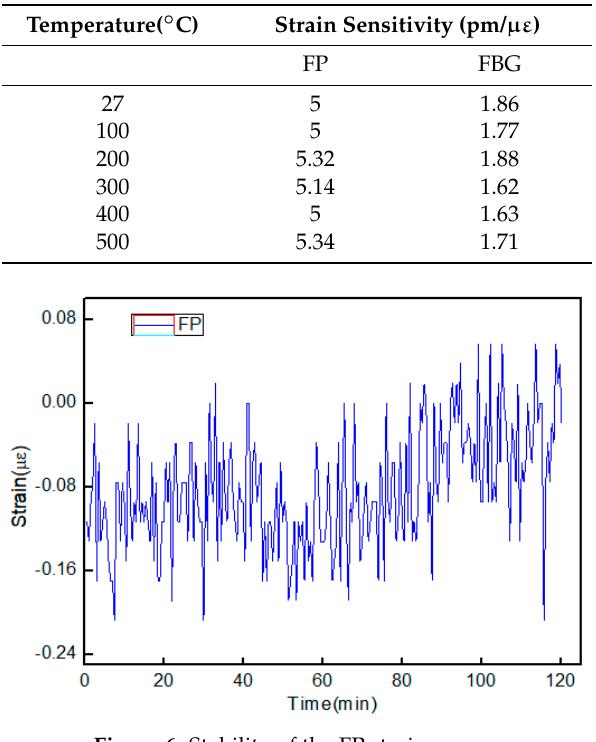
Figure 6. Stability of the FP strain sensor.